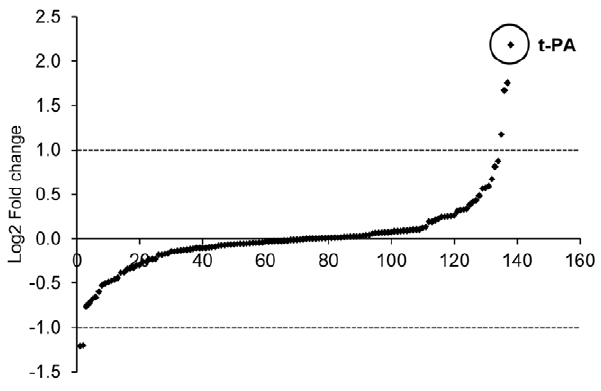
Figure 6. Effect of VPA on the mRNA expression of haemostatic genes. HUVECs (from four individuals) were stimulated with 4 mM VPA for 24 h and mRNA from treated and untreated cells were analyzed using the Human Gene 1.0 ST microarray. Haemostasis genes (a total of 138 genes) were identified using the Amigo database and plotted in the order of increasing log2 fold change. Probe sets with a log2 ratio above + 1 or below 2 1 and a significantly changed expression (p , 0.05, FDR adjusted p-value) were classified as regulated. The dot representing t- PA is highlighted (log Fold Change 2.18). The other regulated haemostasis genes are: Tissue factor pathway inhibitor 2 (TFPI2) (log Fold Change 1.18), signal peptide CUB domain EGF-like 1 (SCUBE1) (log Fold Change 1.67), coagulation factor II (thrombin) receptor-like 2 (F2RL2) (log Fold Change 1.75), P-selectin (log Fold Change 2 1.21) and fermitin family homolog 3 (drosophila) (FERMT3) (log Fold Change 2 1.20).